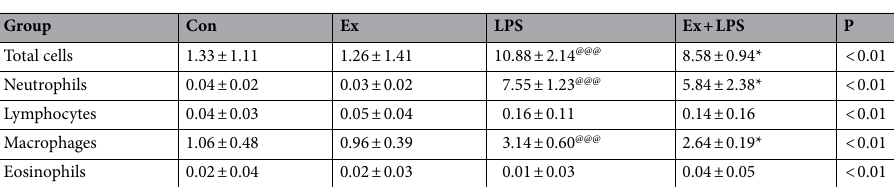
Table 1. Total and differential cell counts in BALF (cells/mL). The number of total cells, neutrophils, and macrophages, lymphocytes, and eosinophils in BALF was measured. @ P < 0.05, Con versus LPS groups. * P < 0.05, LPS versus Ex + LPS groups.